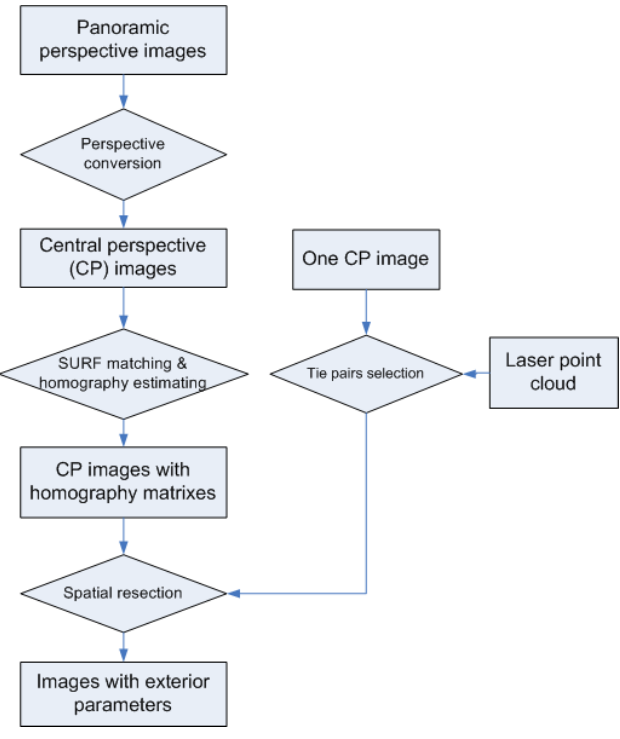
Figure 3. Registration between laser points and